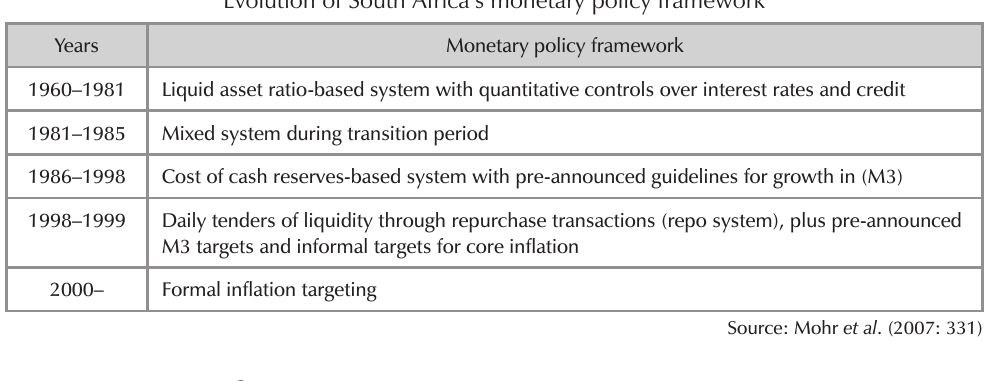
Evolution of South Africa’s monetary policy